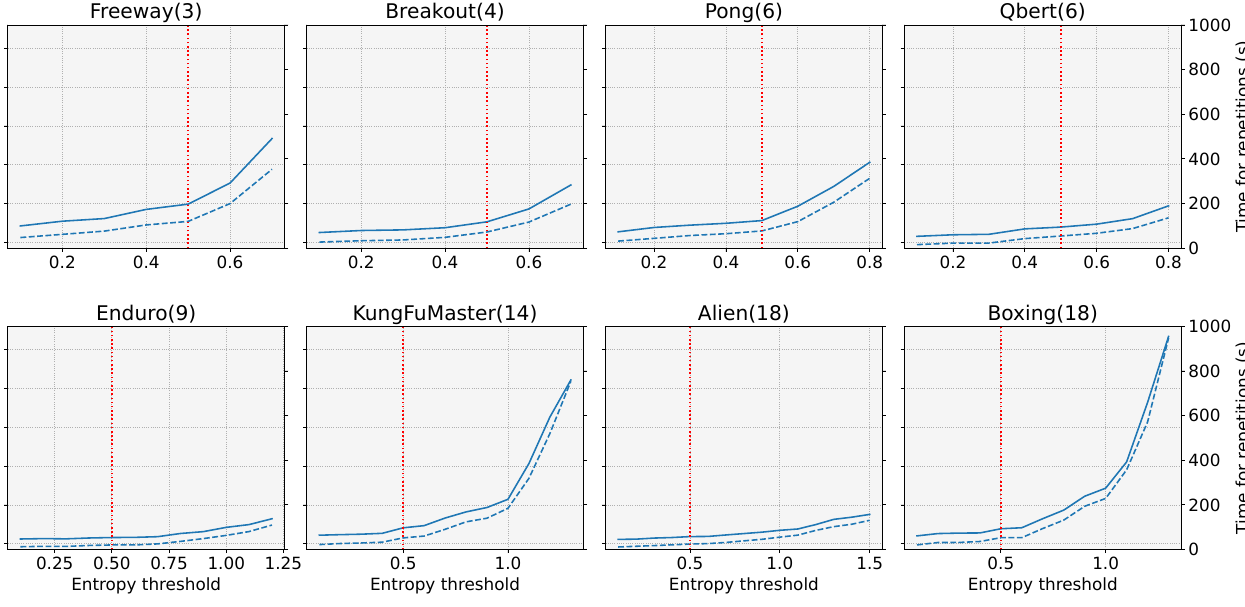
Figure 9. The number (solid line) and time (dashed line) for initialization by the entropy-aware model initialization along the different entropy threshold ( h th